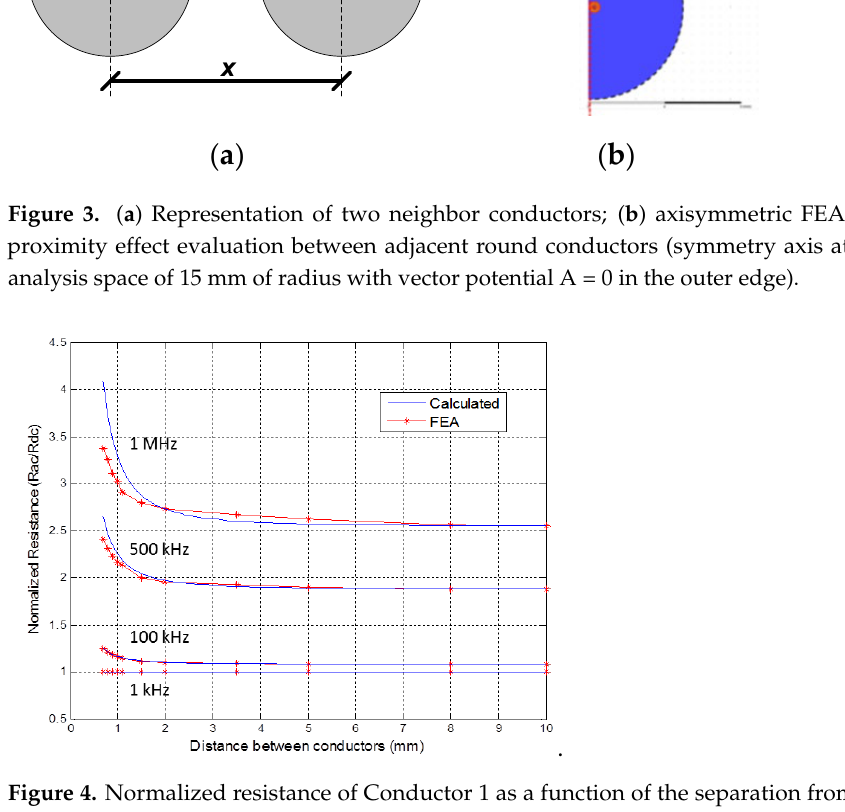
Figure 4. Normalized resistance of Conductor 1 as a function of the separation from Conductor 2 (center-to-center) at different frequencies.